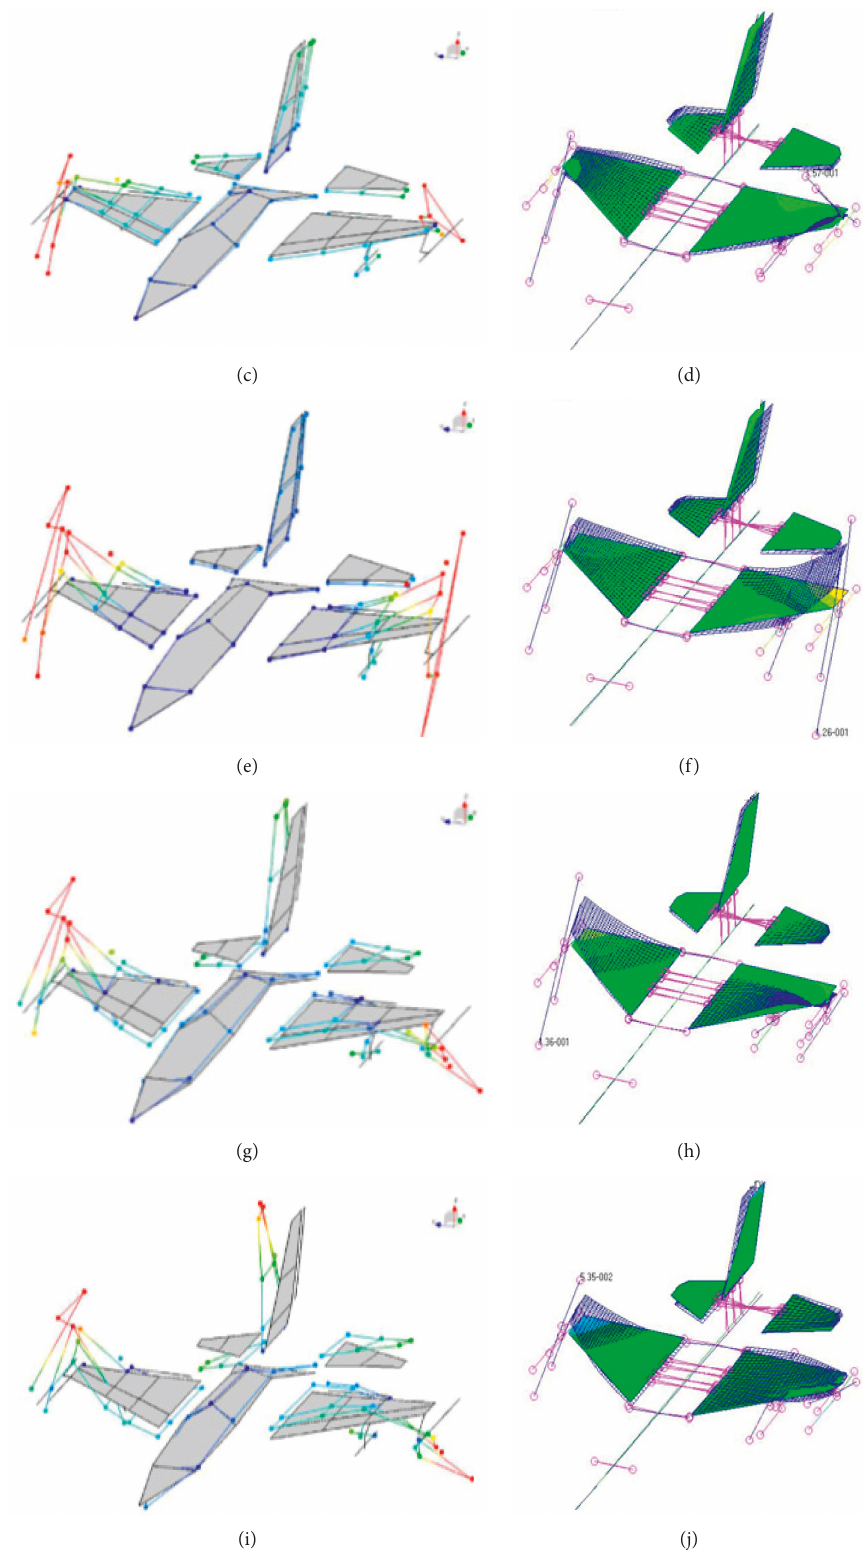
Figure 10: Verification of first five elastic modes (left: reference [16]; right: updated model): (a) mode 1-reference [11], (b) mode 1-updated model, (c) mode 2-reference [11], (d) mode 2-updated model, (e) mode 3-reference [11], (f) mode 3-updated model, (g) mode 4-reference [11], (h) mode 4-updated model, (i) mode 5-reference [11], and (j) mode 5-updated